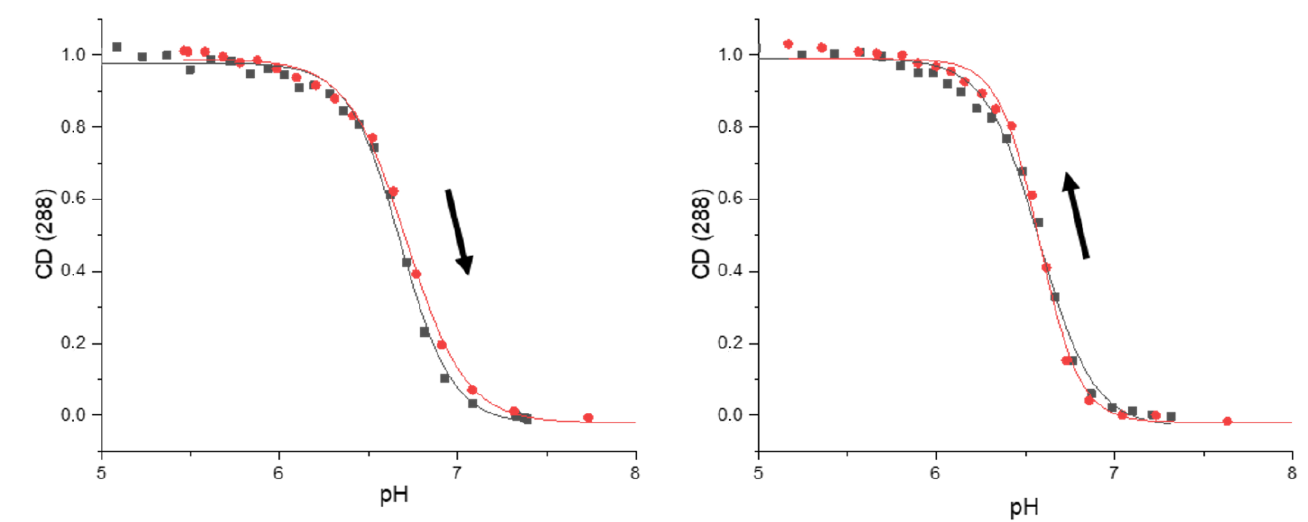
Figure 5. Representative pH-dependent denaturation/renaturation of i-DNA: normalized changes of ellipticity at 285 nm in the course of potentiometric titrations of bcl-2 performed in the absence (black points and curves) and in the presence (red points and curves) of 20 µM IMC-48 . For the detailed conditions, cf. Table 2 legend. Left : alkali (denaturing) titration; right : acid (renaturing) titration. The arrows indicate the denaturing/renaturing processes.